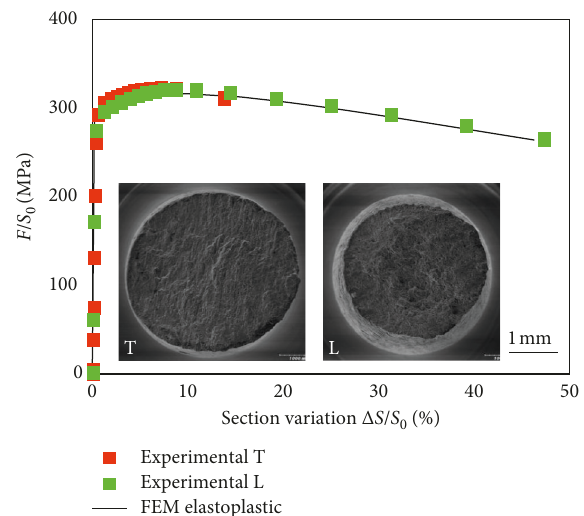
Figure 5: Tensile tests: experimental and simulation with elasto- plastic hardening law (FEM).